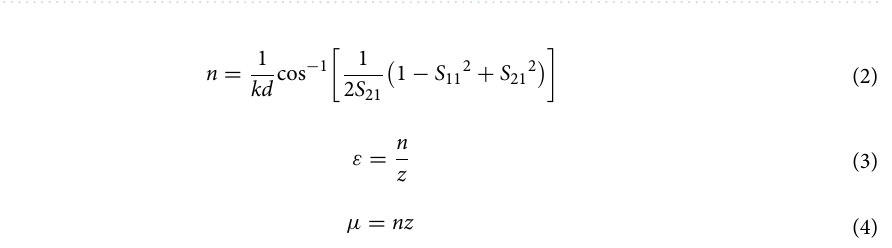
Figure 1. Various structures of proposed antenna designs (a) patch structure with switches formulated with the help of pin diodes, (b) top view of patch structure (c) 3D view of 6 × 5 TW double layer structure followed by a patch layer, (d) 3D view of three layer SRR followed by a patch layer, (e) 3D view of 6 × 5 TW four layer structure followed by a patch layer, (f) front view of three layer SRR followed by a patch layer, (g) top view of SRR, (h) top view of 6 × 5 TW